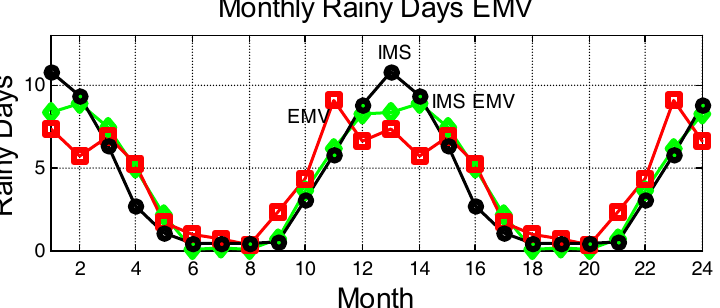
Figure 6. Monthly average value of the rainy days for about 26 years (1990–2015) relative to 184 localities of the Holy Land (curve IMS, circles), or for 3 years and only 380 days (according to Table 4) (curve IMS EMV, diamonds), Equation (4), from the IMS data bank. The curve labeled EMV (squares) shows the number of monthly days obtained from the EMV, Equation (8). Notice that each annual cycle is repeated twice for showing continuity.